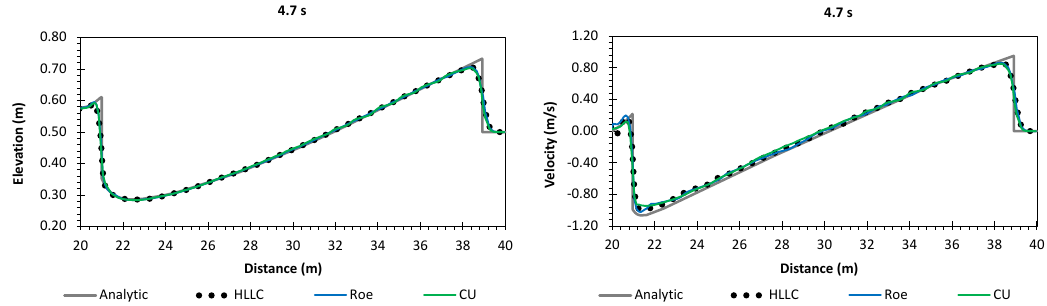
Figure 6. Case 1: comparison between analytical and numerical results at 4.7